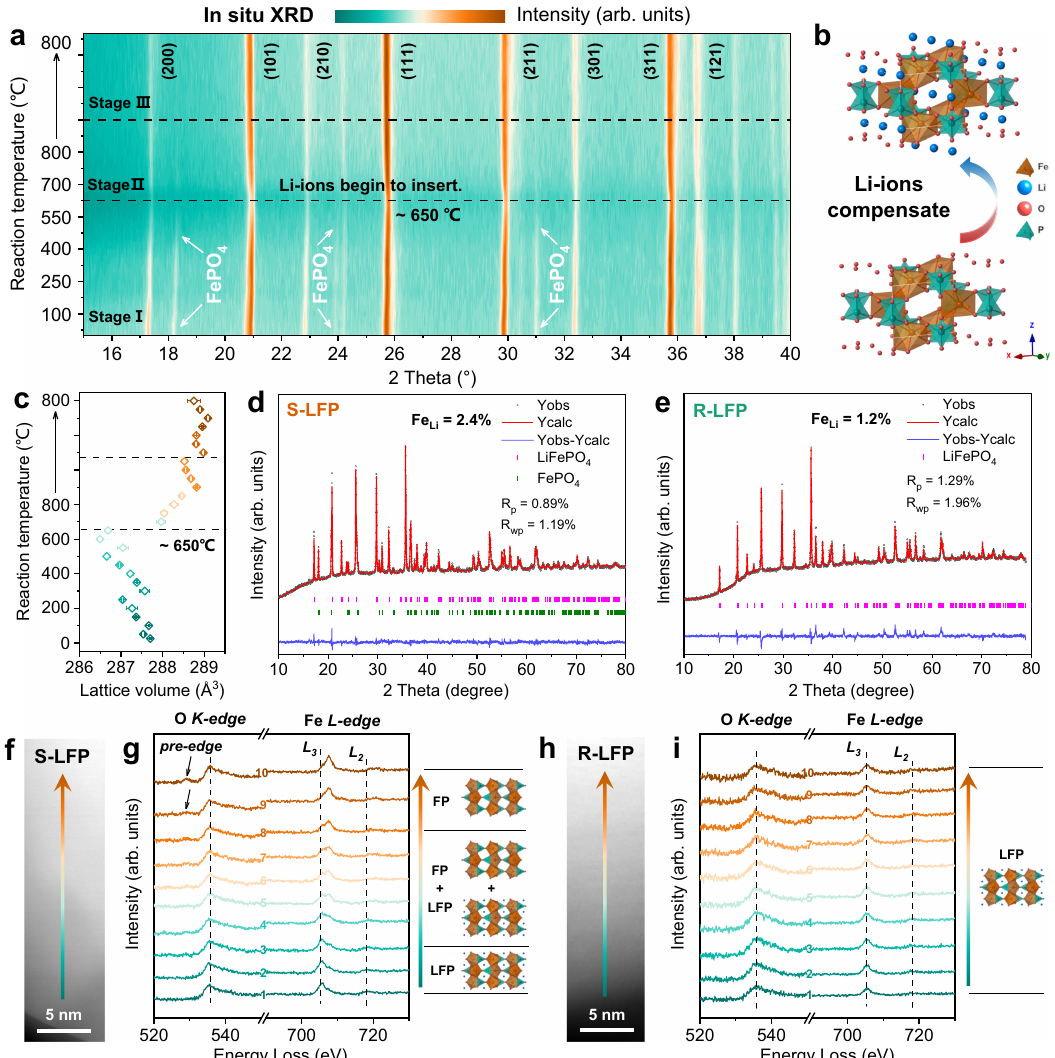
Fig. 4 | Analysis of the regeneration mechanism of LFP cathodes using Li 2 DHBN. a Contour plots of XRD patterns as a function of temperature in the selected 2 theta range. b Schematic showing that Li vacancies have been fi lled and crystalline structure recovers to the original state after direct